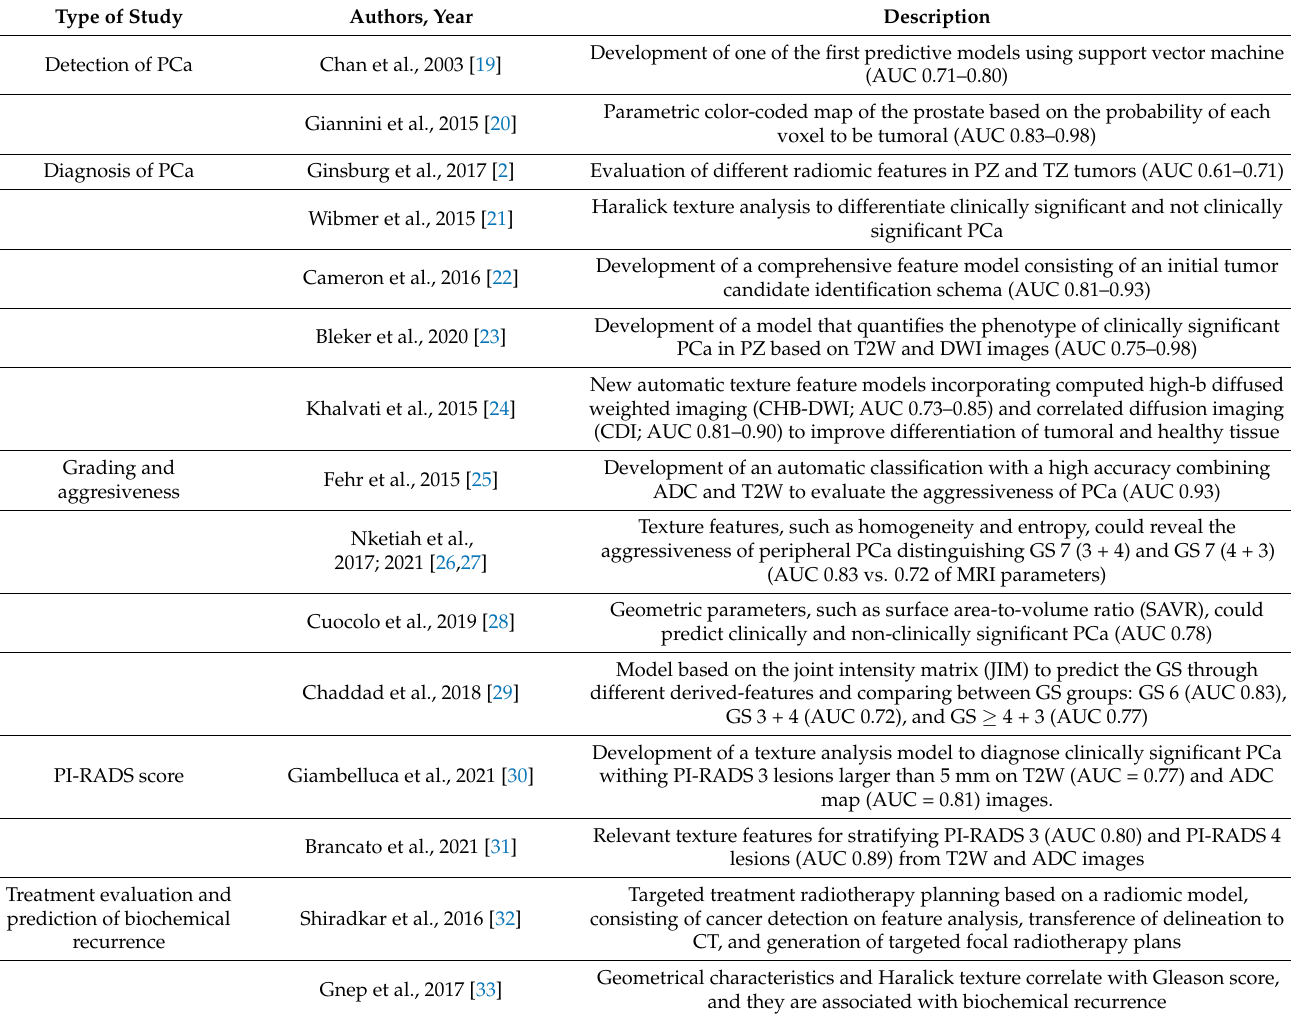
Table 2. Summary of most relevant studies on radiomic studies for prostate